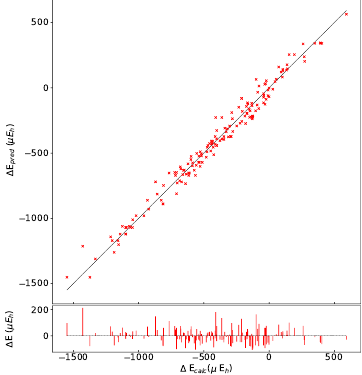
Figure A4. Comparison between the B3LYP relative energies ( ∆ E calc ) and the relative energies predicted according to the 12 interaction model described in the text ( ∆ E pred ) for the 162 SICs. Energies refer to 2 f.u. Top: E pred as a function of E calc . The even distribution with respect to the perfect agreement straight line (dashed line) confirms the good quality of the model. Bottom: Deviation ( ∆ E pred - ∆ E calc ) as a function of ∆ E calc . The two panels share the horizontal scale. The energy differences are a small fraction of the energy interval covered by the set of SICs; only 4 exceed 10% of the energy